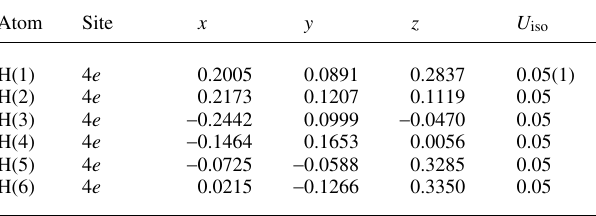
Table 2. Atomic coordinates and displacement parameters (in Å 2 ) .